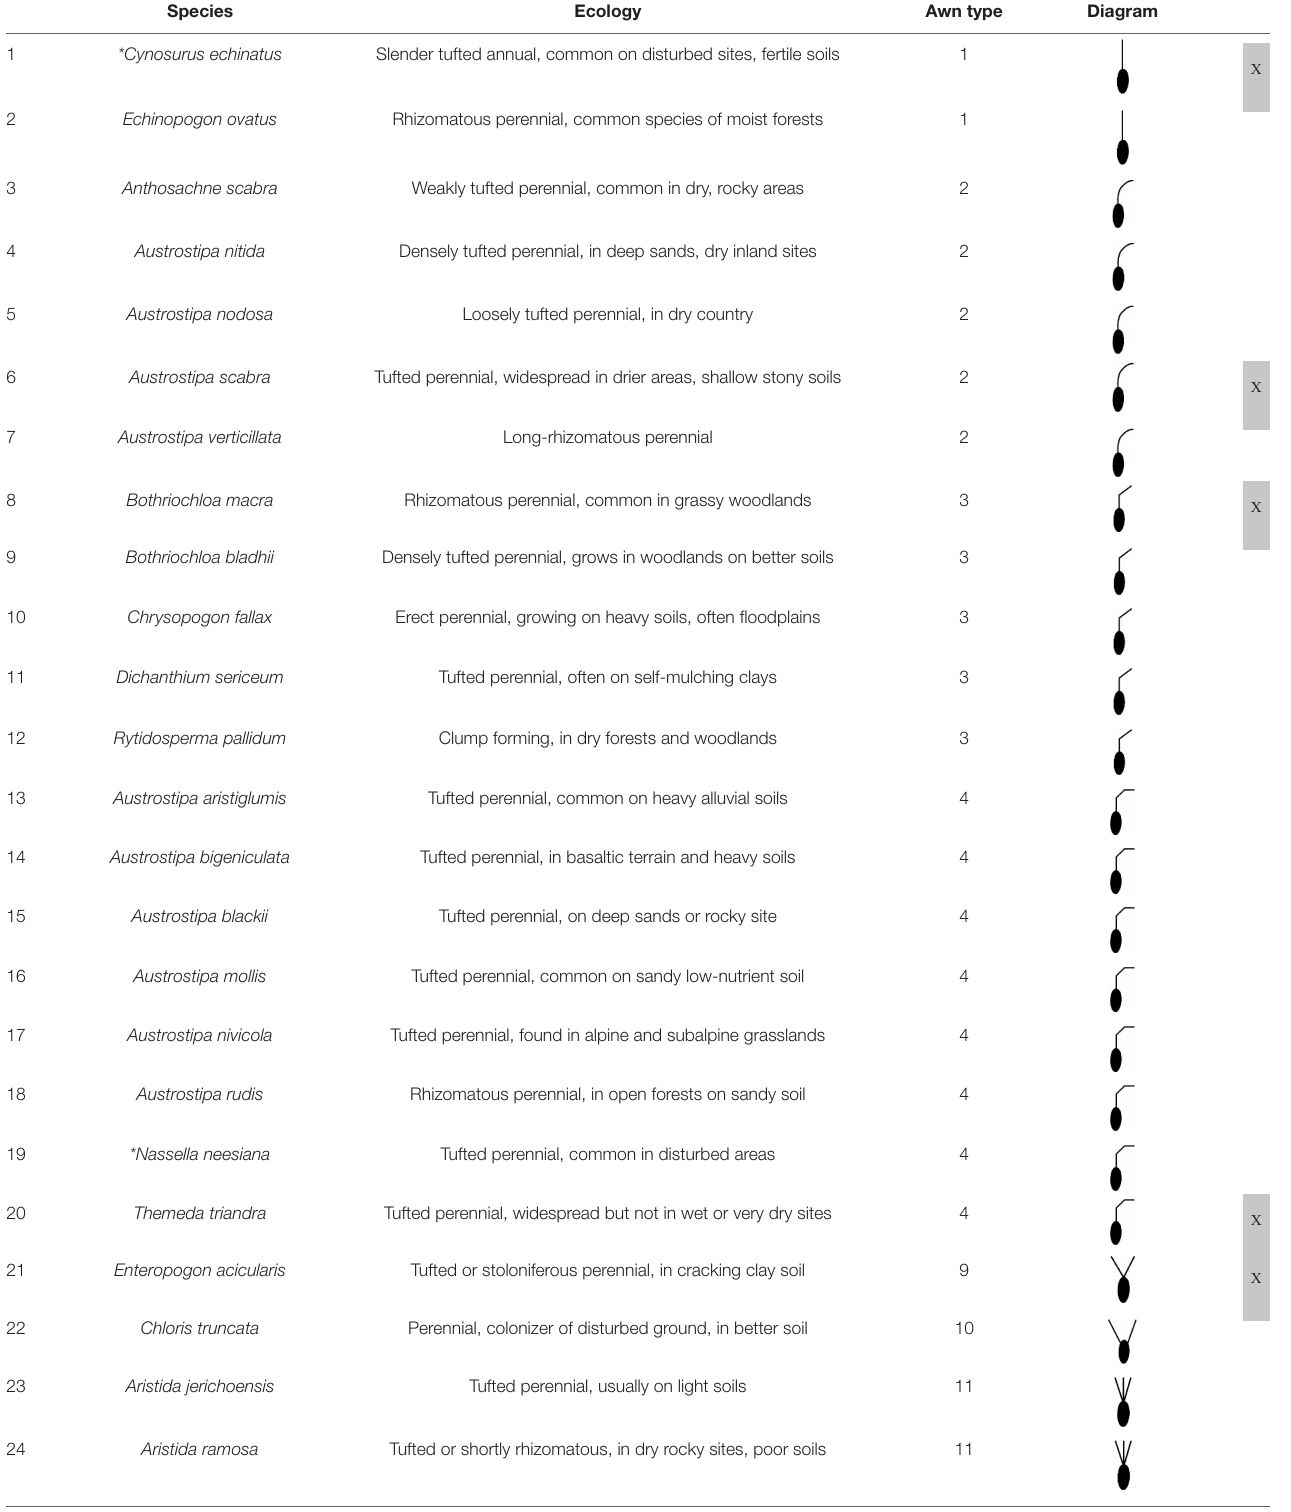
TABLE 1 | Species from which diaspores were obtained for use in the awn function experiments. Species Ecology Awn type